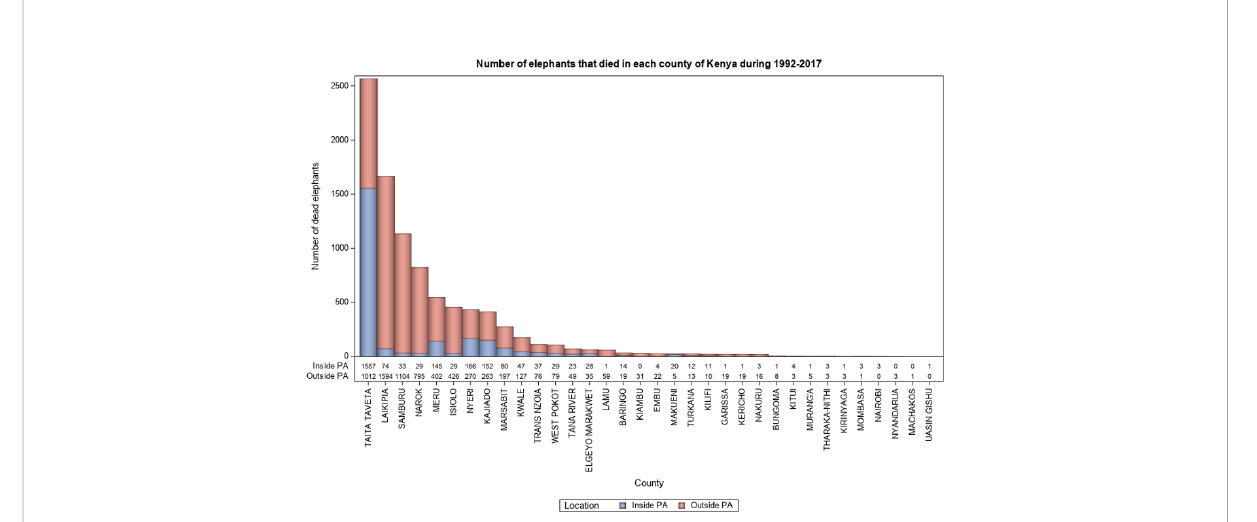
FIGURE 6 Elephant mortality inside and outside PAs by County in Kenya during